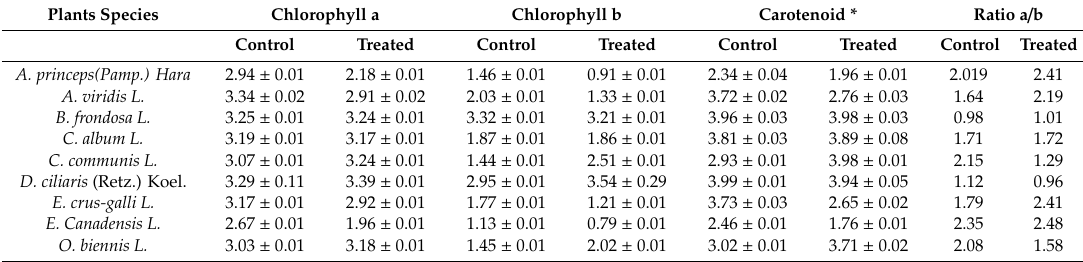
Table 6. E ff ect of aqueous extract of Miscanthus leaves on photosynthetic pigments of weeds. Plants Species Chlorophyll a Chlorophyll b Carotenoid * Ratio a / b Control Treated Control Treated Control Treated Control Treated A. princeps(Pamp.) Hara